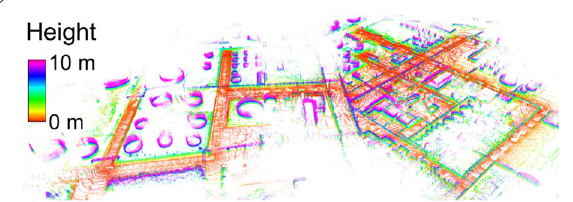
Fig. 11 3D map built from FS 2.0 based on GPS and LIDAR from a side view